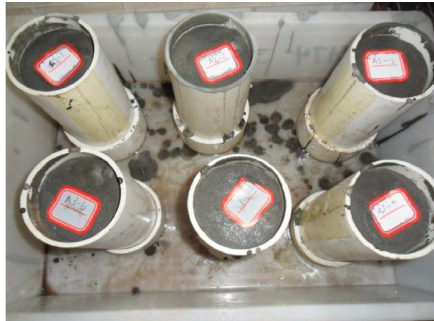
Figure 3: Sample preparation.